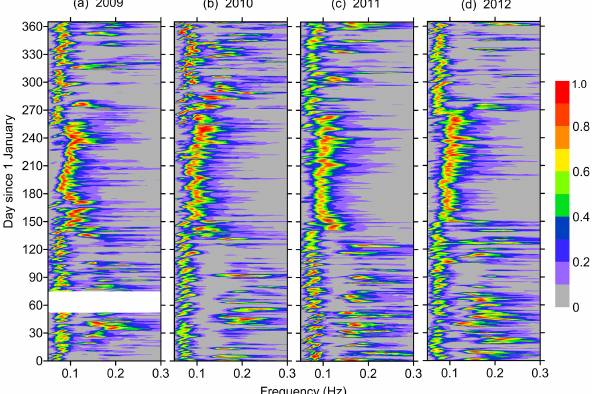
Figure 3. Temporal variation in normalised wave spectral energy density during 2009–2012. The white patch indicates the gap in the data.